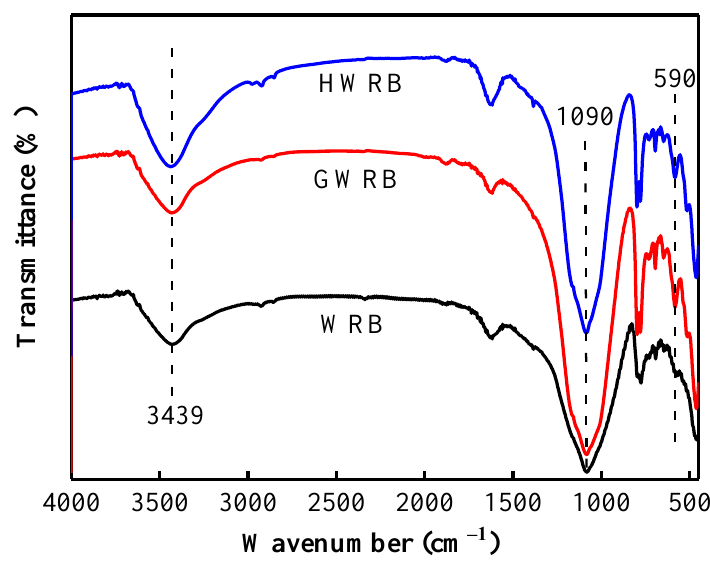
Figure 3. The FTIR of WRB, GWRB, and HWRB.